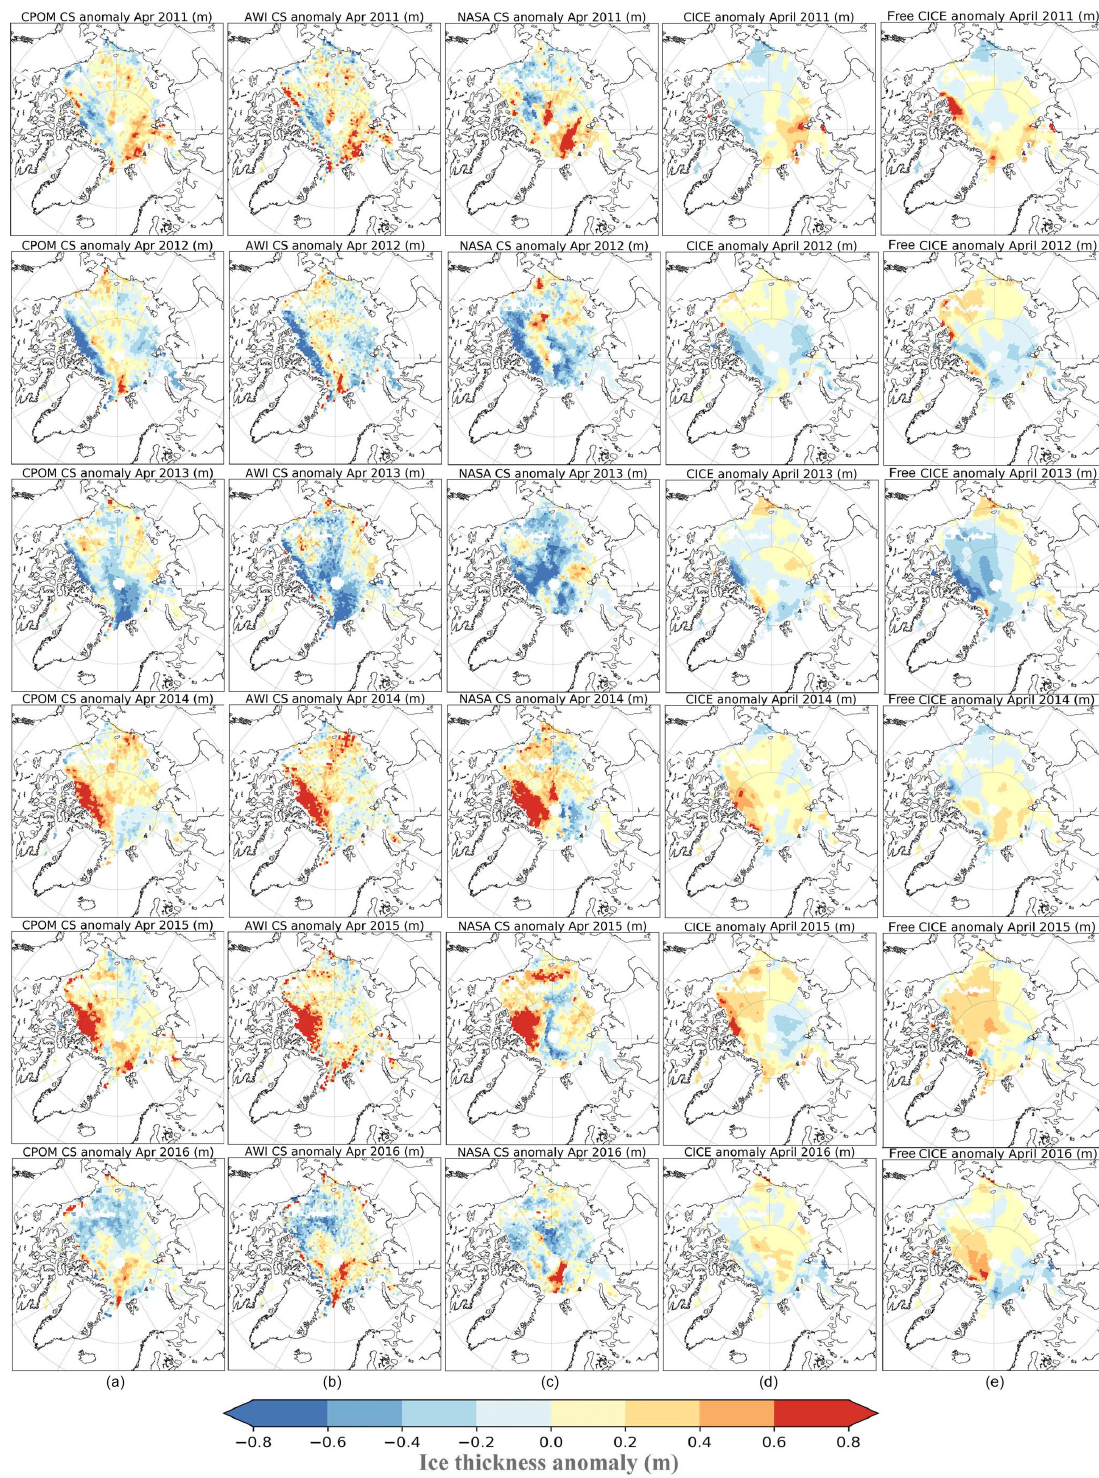
Figure 5. Anomaly of April ice thickness from 2011 to 2016 in meters relative to the 2011 to 2017 mean from CryoSat-2 CPOM (a) , AWI (b) , NASA (c) , CICE simulations initialized with November CPOM CryoSat-2 thickness fields (d) and CICE simulations not initialized with CryoSat-2 thickness (e) . Grid points with less than 100 individual measurements and a mean sea ice thickness of less than 0.5m are not